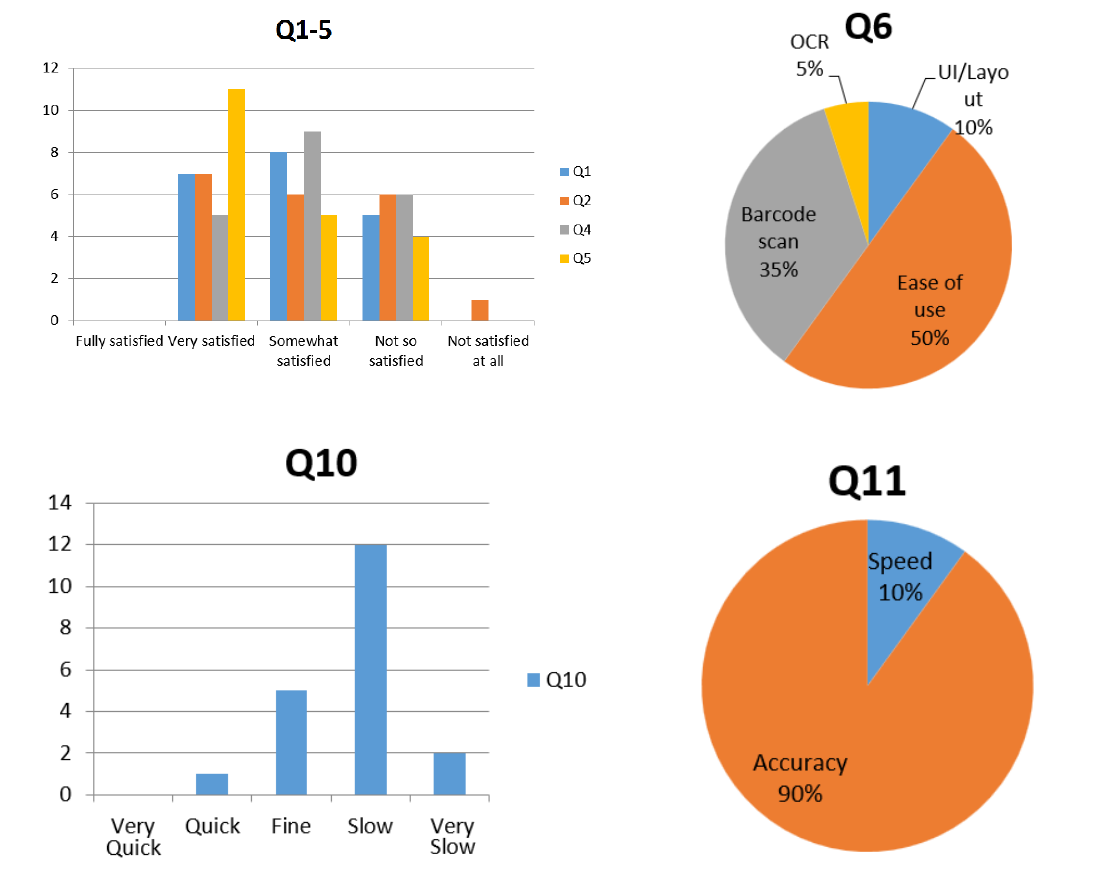
Figure 11. Responses from our user